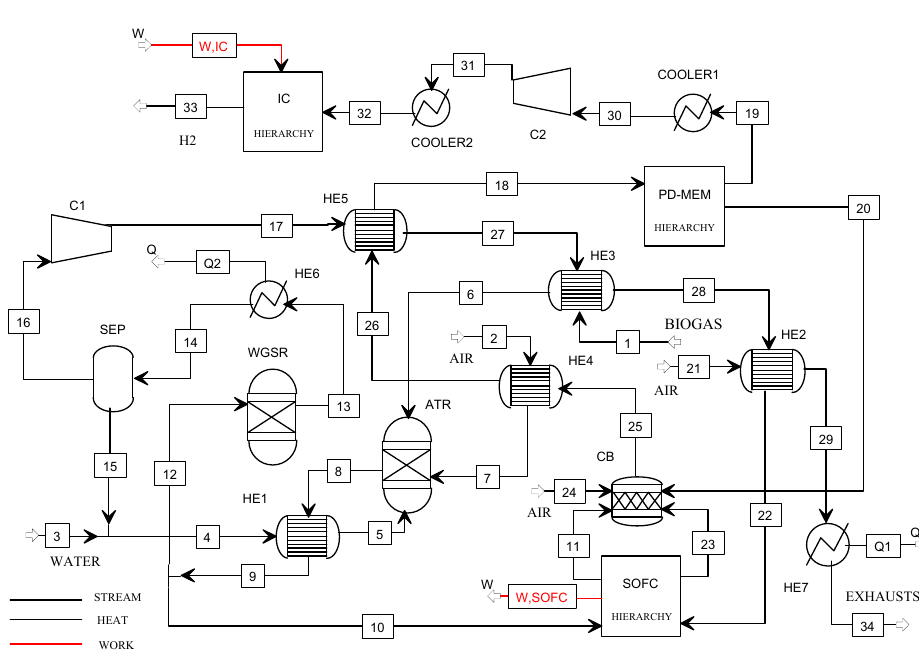
Figure 4. Flowsheet of the B2H_SOFC plant model.